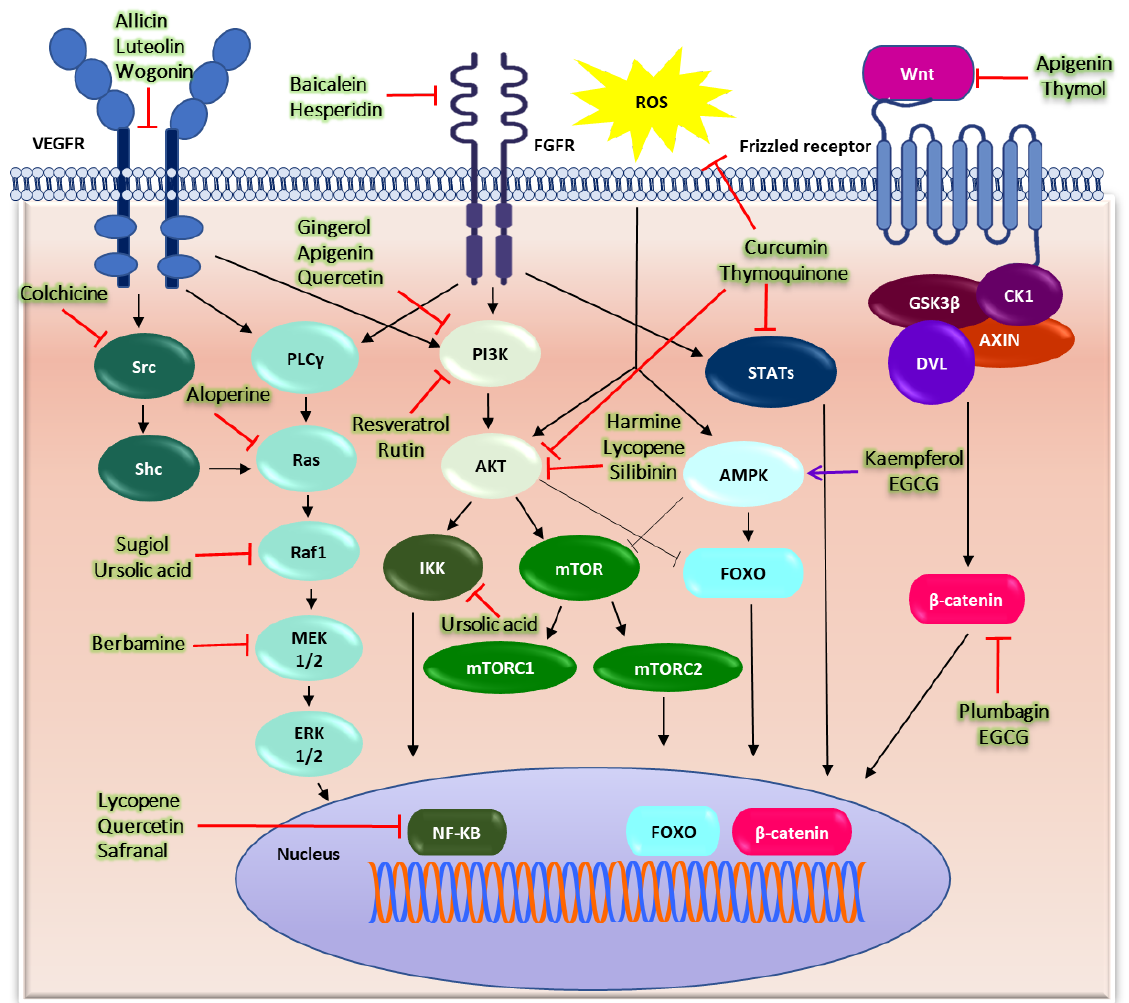
Figure 2. Important cellular mechanisms involved in cancer and mechanisms of action of phyto- chemical drugs. Growth factors, such as vascular endothelial growth factor and fibroblast growth factor, bind with their respective receptors, resulting in their phosphorylation, followed by the acti- vation of downstream signaling pathways, such as the PI3K/Akt, PLCγ, and STAT pathways. Akt activates IKK, which is responsible for the activation of the NF- κB signaling and mTOR pathway; IKK exerts its effect on cells by regulating the hypoxia-induced factor. ROS activates the Akt and AMP-activated protein kinase (AMPK) pathways by inducing endoplasmic reticulum stress. AMPK activates the tumor suppressor transcription factor (FOX O) and inhibits the action of mTOR. Wnt proteins suppress glycogen synthase kinase- 3β (GSK - 3β) by binding to frizzled receptors, disrupt- ing the β - catenin complex (destructive complex). β -catenin accumulates in the cytoplasm, translo- cates to the nucleus, and induces cell proliferation, which promotes cancer by activating Wnt-regu- lated genes. Different phytochemicals act on different targets to exhibit anticancer activity.